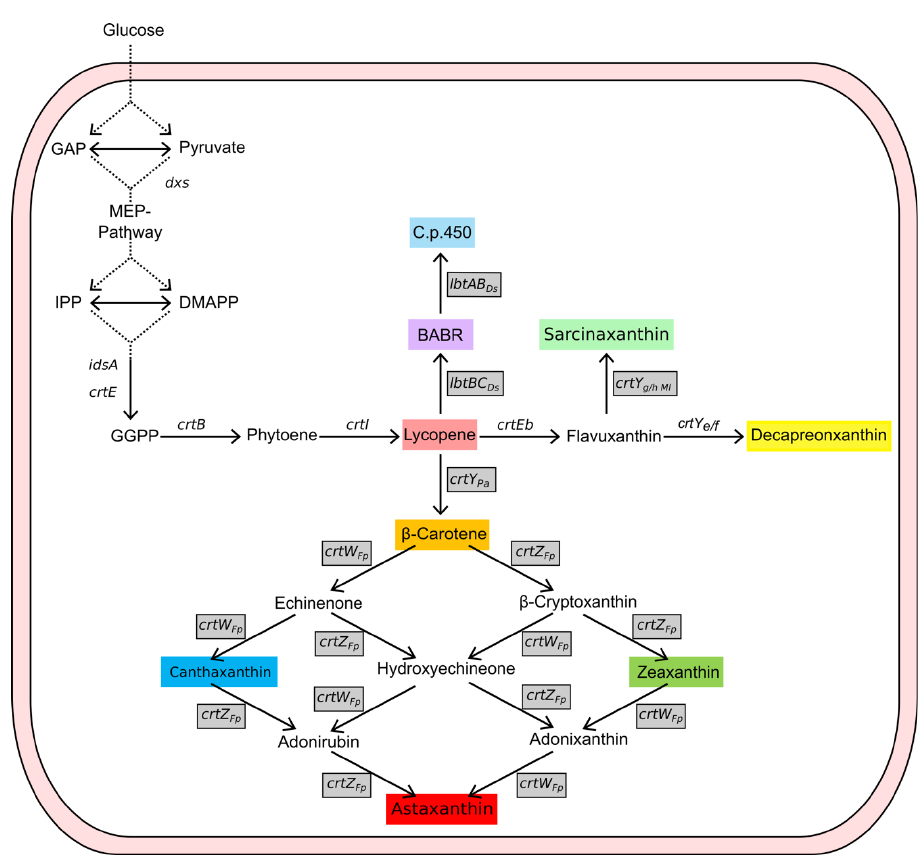
Figure 1. Carotenoid Biosynthesis in C. glutamicum . Gene names are given next to the reactions catalyzed by their gene products. Heterologous genes are depicted with a grey box. GAP: Glyceraldehyde 3-phosphate; IPP: isopenthenyl pyrophosphate; DMAPP: dimethylallyl